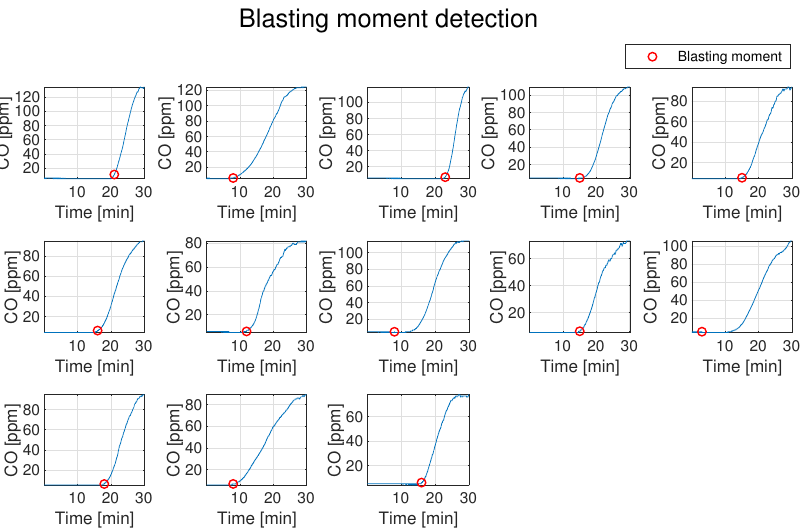
Figure A2. The blasting moment detection—Part II.